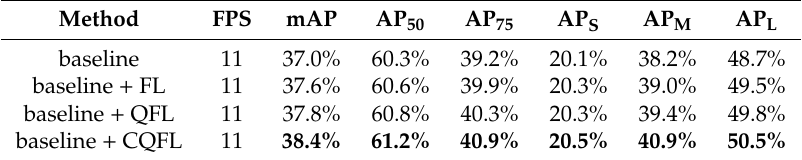
Table 3. The performance improvement of the baseline by di ff erent loss functions.